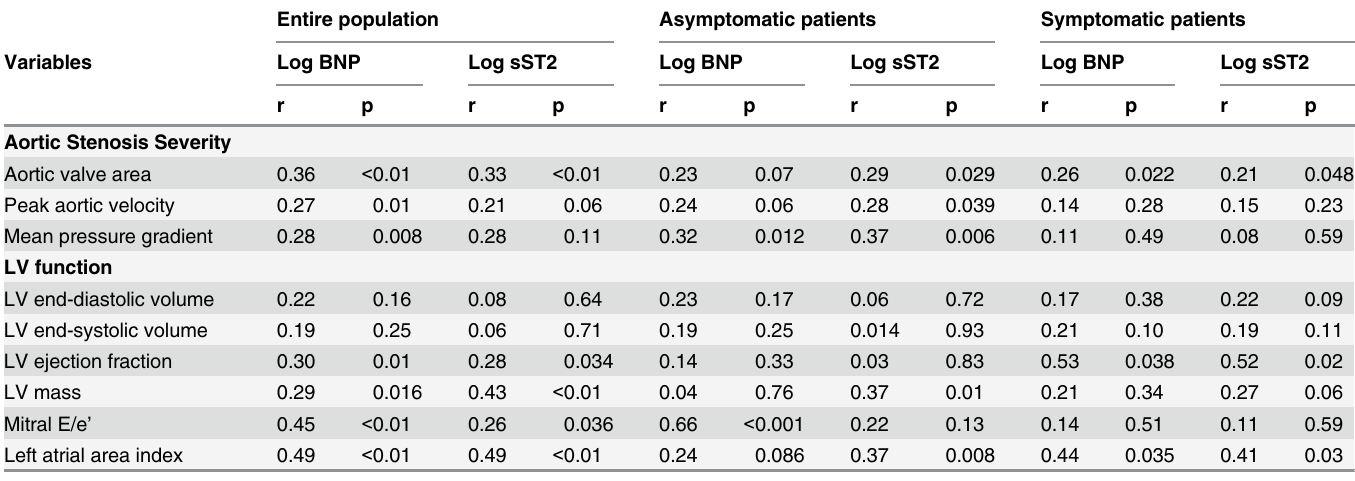
Table 2. Echocardiographic correlates of biomarkers. Entire population Asymptomatic patients Symptomatic